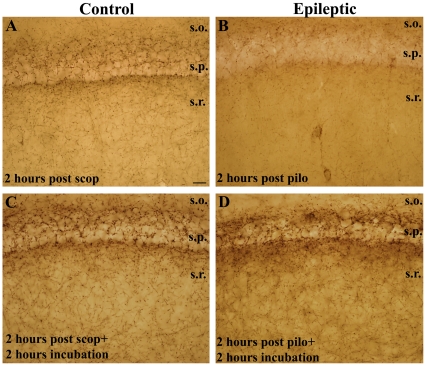
Reversible changes in CB1-R-staining in slice preparation (acute phase).In CA1 region of surviving brain slices 2 hours post pilocarpine a massive decrease is seen in CB1-R staining in strongly epileptic animals (B) compared to scopolamine treated controls (A) as it was seen in perfusion-fixed epileptic animals. In contrast, the slices from the same animals which were incubated in ACSF for an additional 2 hours the CB1-R staining in the epileptic tissue (D) did not differ from control slices (C). Scale: 50 µm.